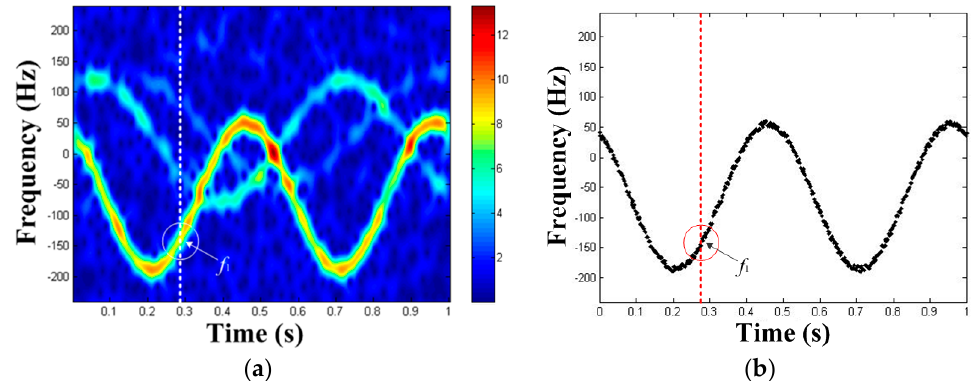
Figure 3. The schematic diagram of TF curve extraction: ( a ) TF curve extraction process, ( b ) TF curve extraction result.